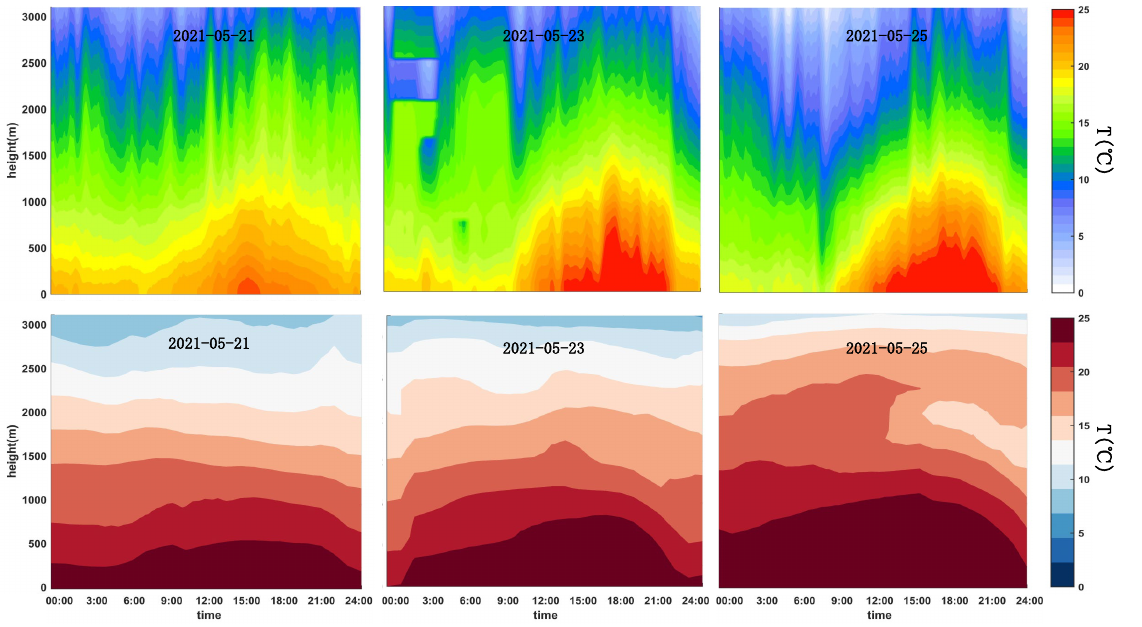
Figure 6. Spatiotemporal distribution of temperature from microwave radiometer ( top ) and ERA5 reanalysis data ( bottom ).